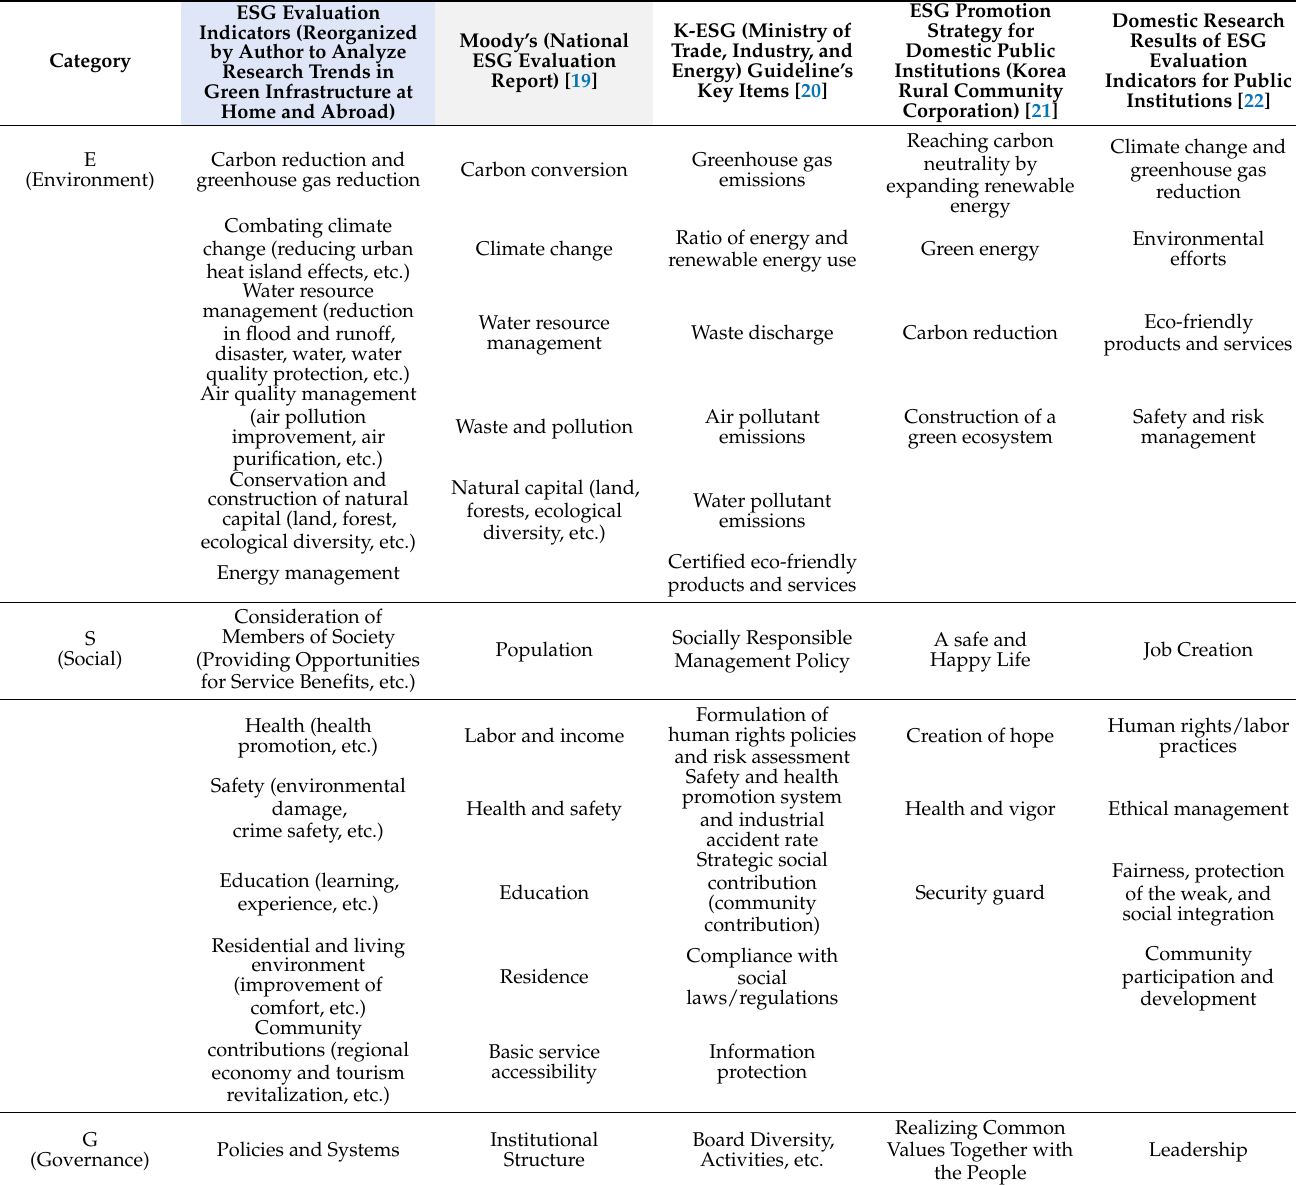
Table 2. Domestic and foreign ESG evaluation